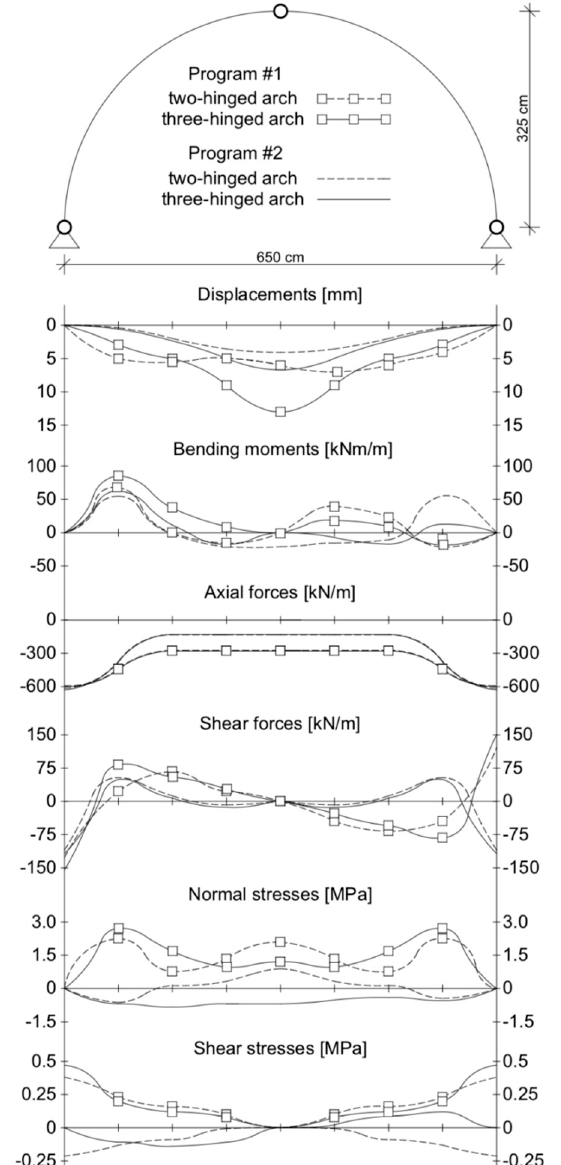
Figure 15. Distribution of analyzed maximum values in the cross-section of the two- and three-hinged arch viaduct in both programs (#1 and #2).